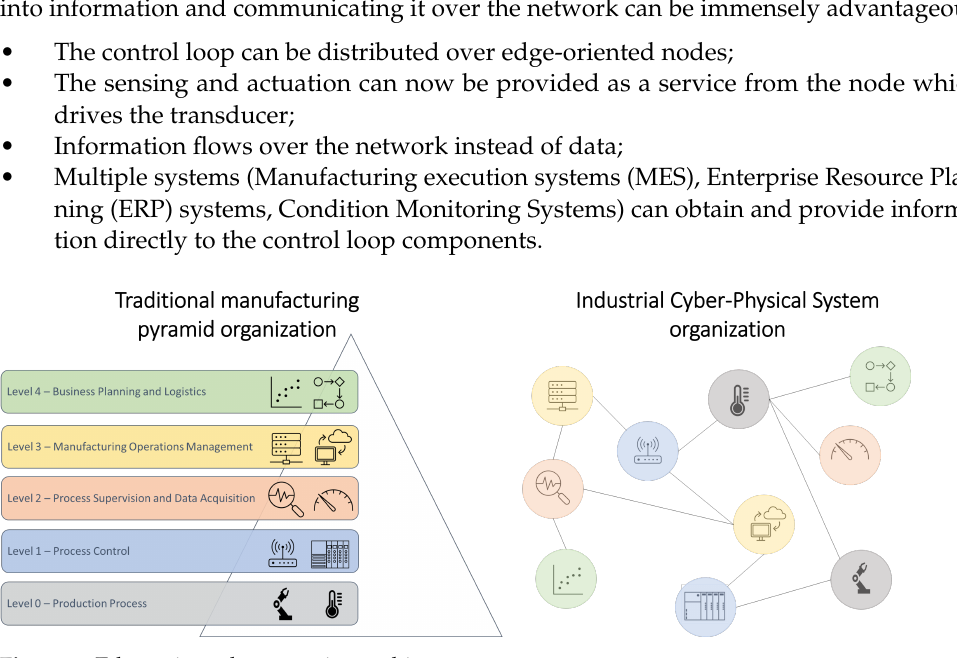
Figure 1. Edge-oriented automation